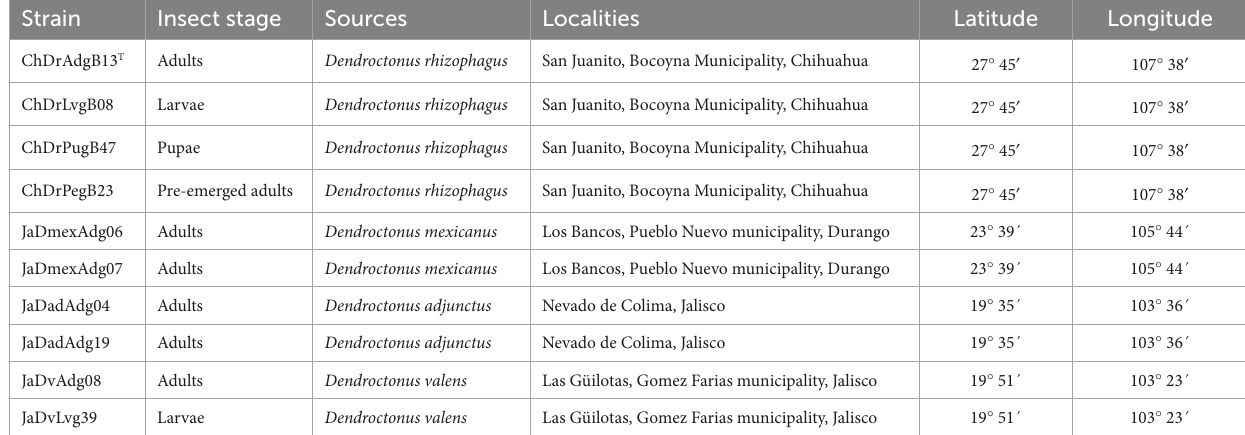
TABLE 1 Bacterial isolates used in this study, Dendroctonus species, localities, and geographic references where they were collected. Strain Insect stage Sources Localities